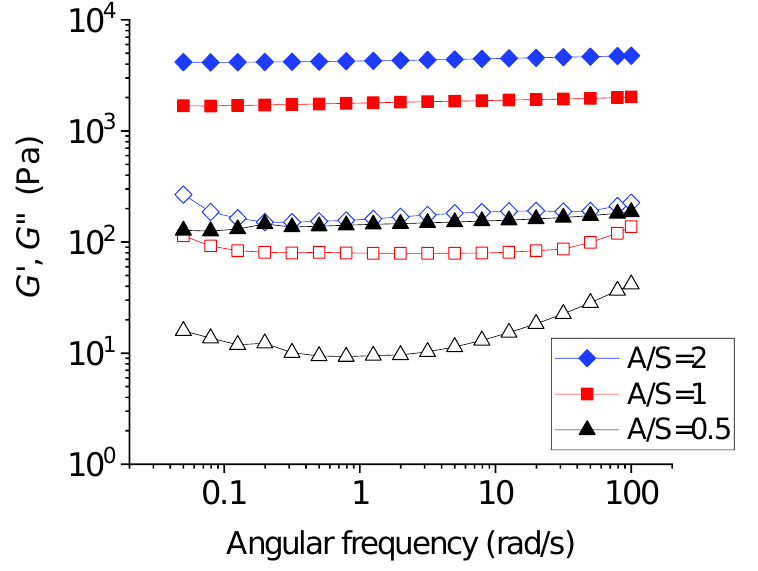
Figure 8. Frequency- dependence of storage shear modulus (G′) and the loss shear modulus (G″), as observed in oscillatory rheological investigations. Data points in the graph: G′— filled symbols; G″— open symbols.